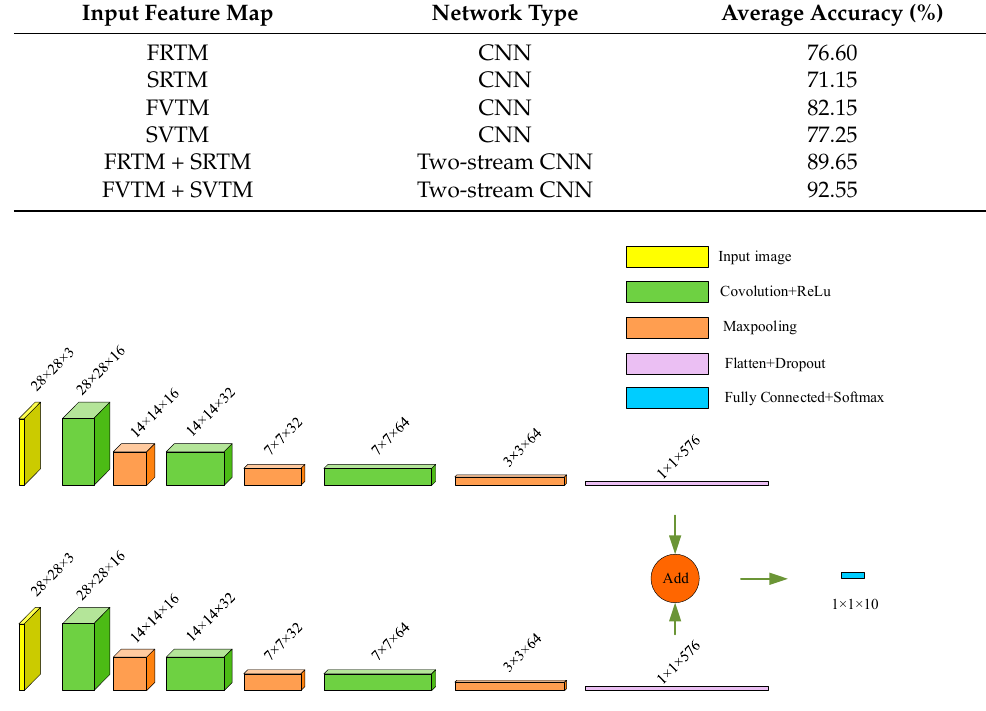
Figure 14. The structure of two-stream CNN.